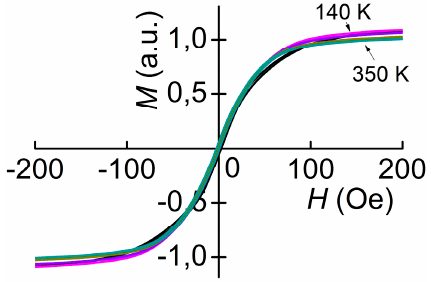
Figure 6. Magnetization curves of the Metglas layer for different temperatures T .